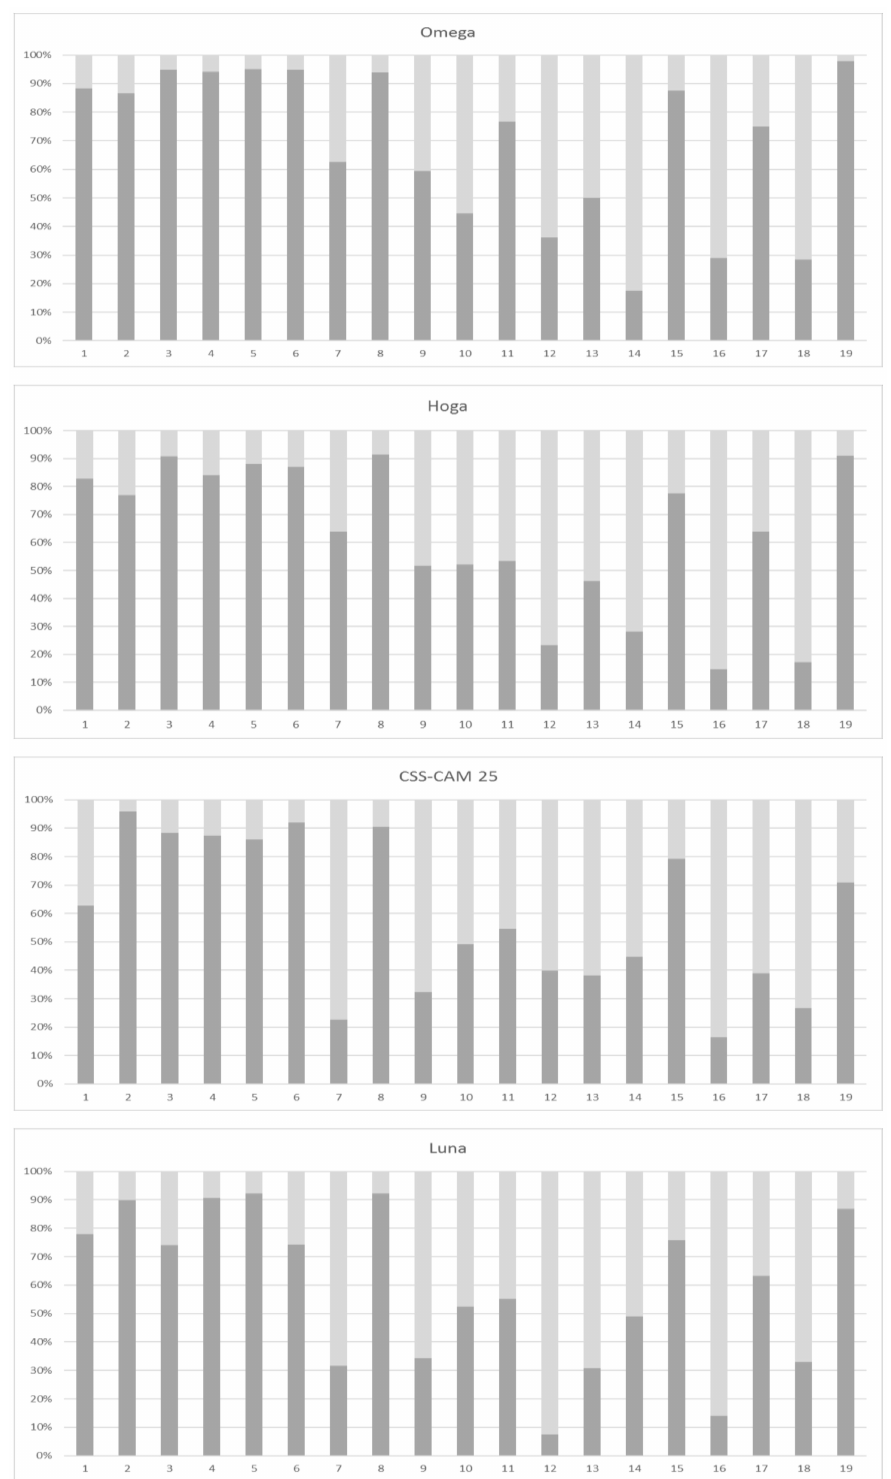
Figure 1. The flavonoid aglicons and phenolic acids composition (%) in spring and winter genotypes of Camelina sativa : 1—Apigenin; 2—Catechin; 3—Kaempherol; 4—Luteolin; 5—Naringenin; 6—Quercetin; 7—Rutin; 8—Vitexin; 9—4-hydroxybenzoic; 10—Caffeic; 11—Chlorogenic; 12—Ferulic; 13—Gallic; 14—p-Cumaric; 15—Protocatechuic; 16—Sinapic; and 17—Syringic; 18—t-Cinnamic;